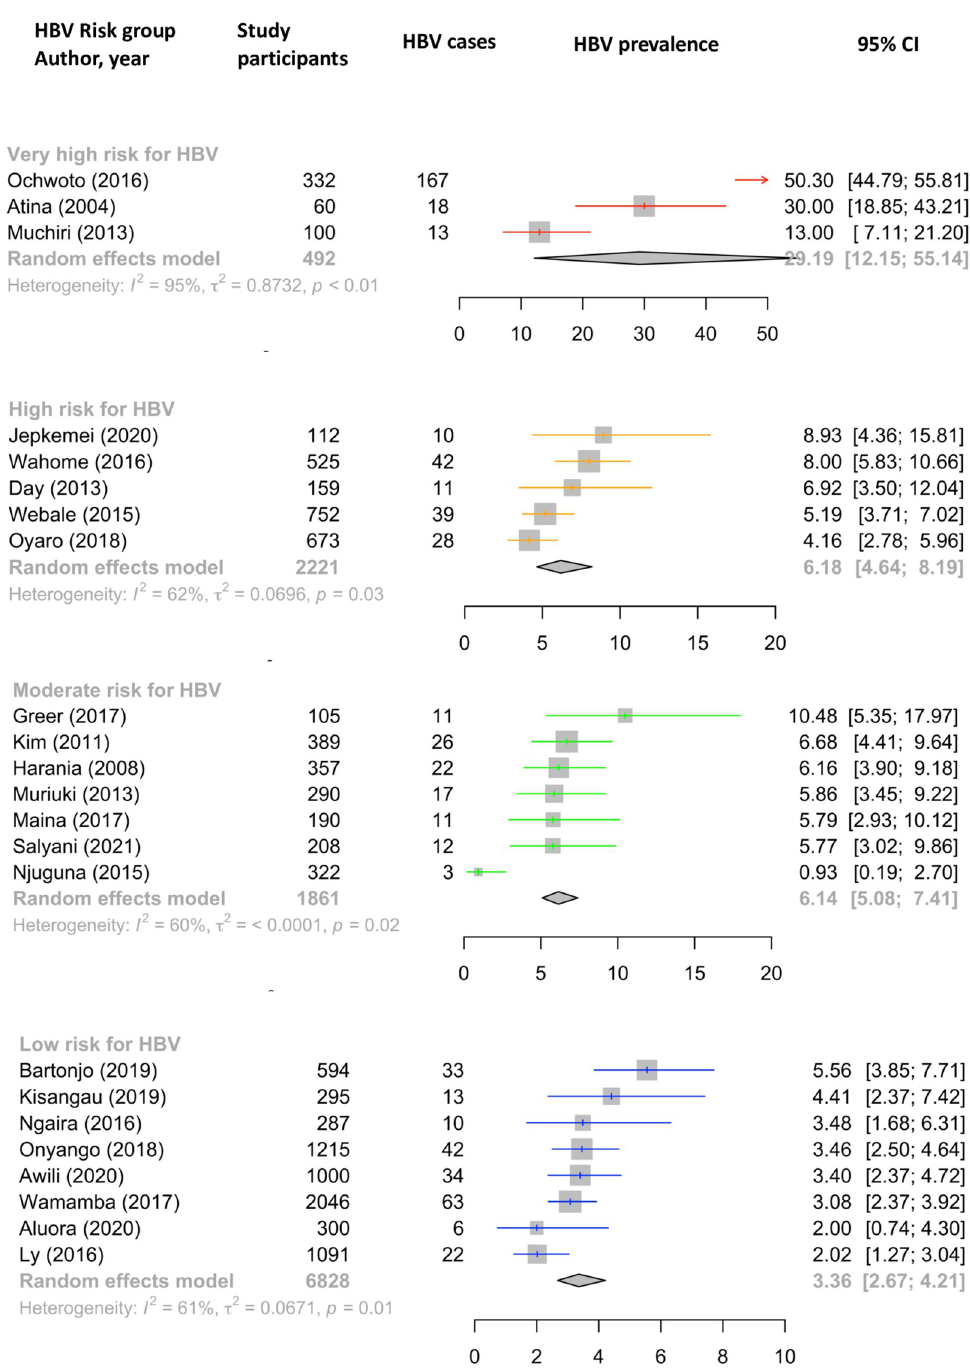
Fig 4. Forest plot showing pooled HBV prevalence for populations in different risk groups by random effects model. Data generated through a systematic review reporting prevalence and genetic data for HBV in Kenya between 2000–2021. In each case, the size of the population included is represented by the size of the square. Point prevalence and 95% Confidence Interval (CI) is indicated for each study. Studies are ordered by HBV prevalence in each risk group.